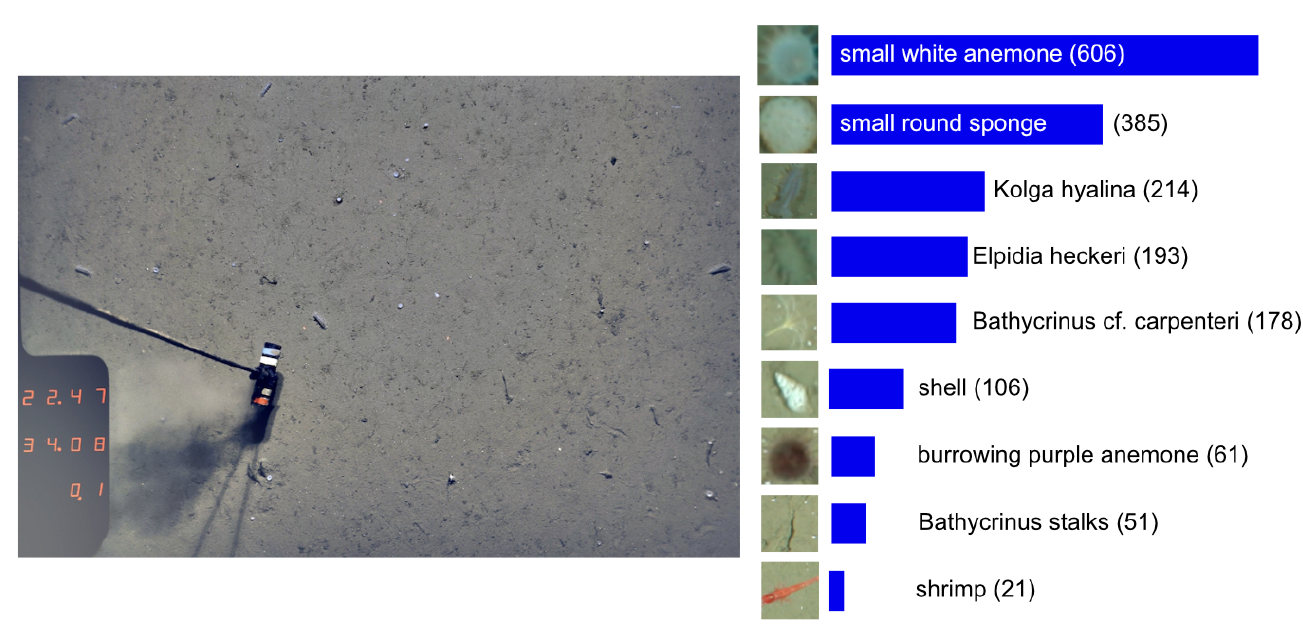
Figure 1. Images from the Hausgarten observatory (HG). Left : An original image. Right : The Hausgarten data set (HG) as used in experiments in Section 4.1. The numbers in brackets indicate the number of samples in a class. IMAGE: AWI OFOS team.